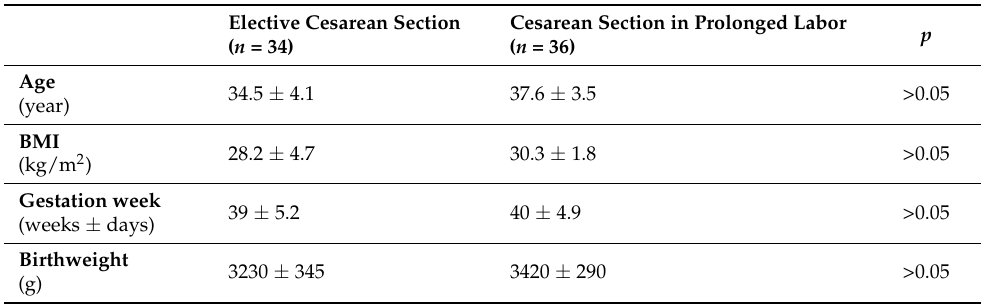
Table 1. Demographic characteristics of the two groups.